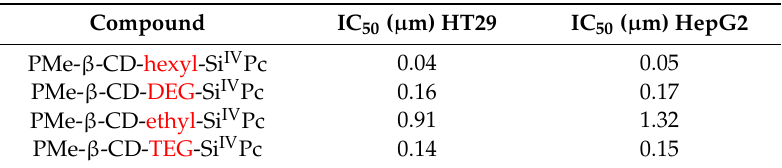
Table 4. IC 50 value comparison of all conjugates against human colon adenocarcinoma (HT29) and human hepatocarcinoma (HepG2) cells.